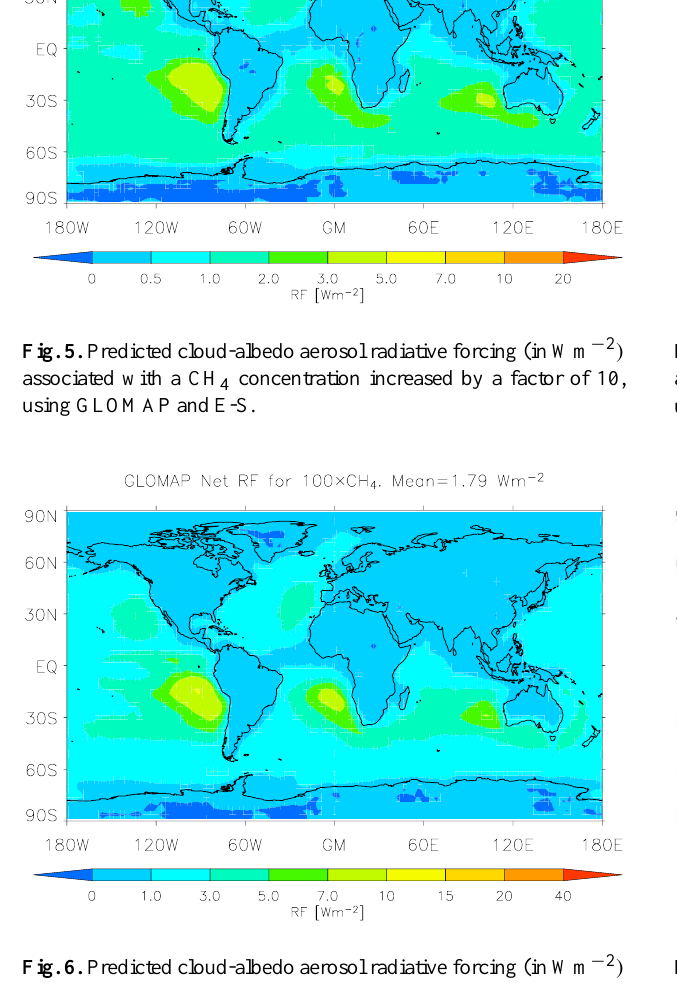
Fig. 8. Predicted cloud-albedo aerosol radiative forcing (in Wm − 2 ) associated with a CH 4 concentration increased by a factor of 100, using GLOMAP and E-S with ECHAM CDNC